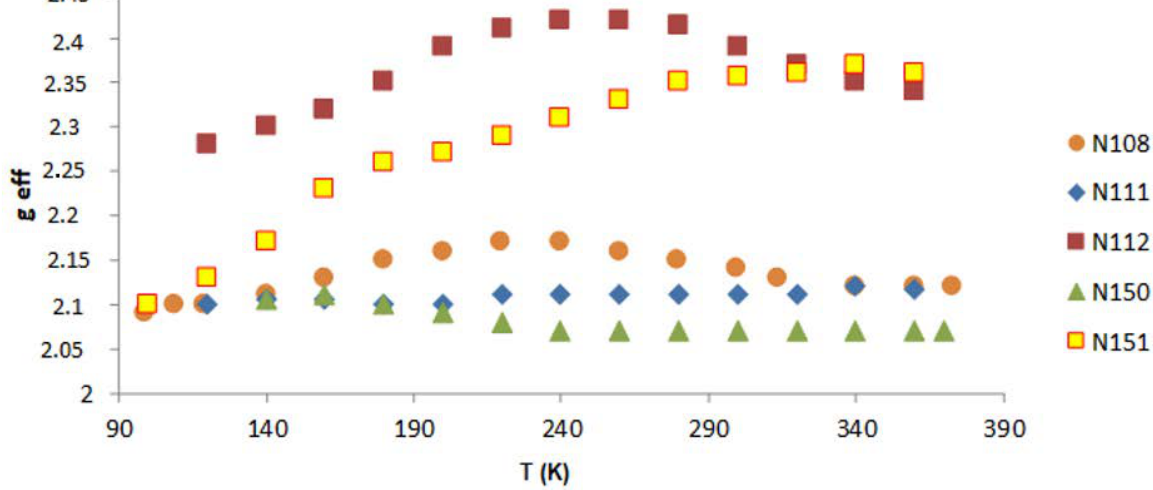
Figure 7. g eff as a function of the temperature for Pb 3+ (g eff ≈ 2).